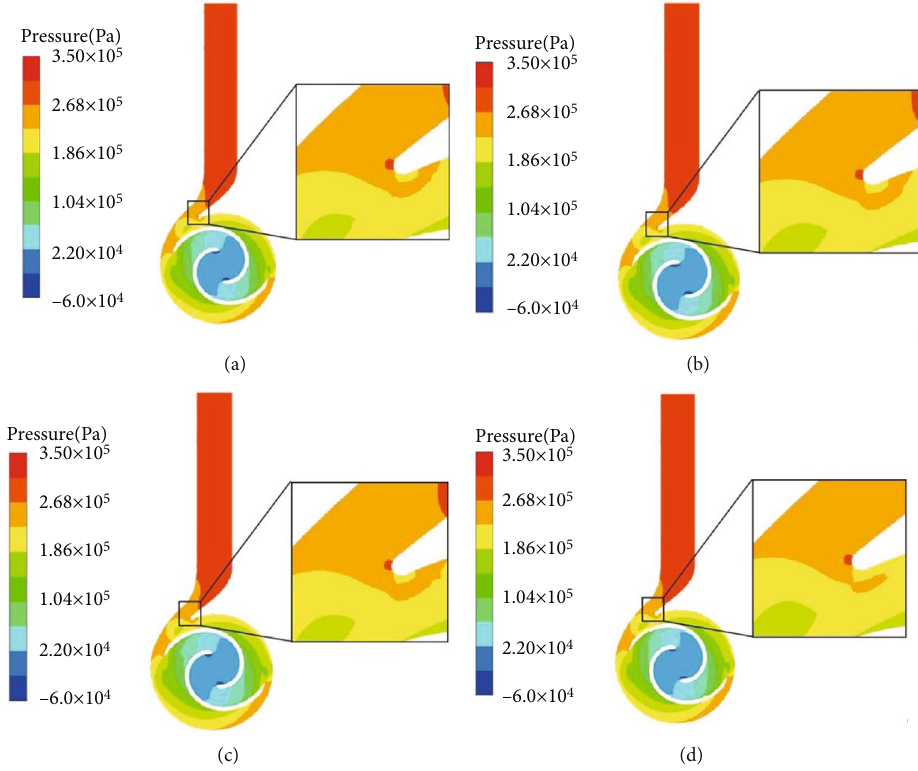
Figure 7: Cross-sectional pressure clouds of four vane double-vane pumps at ρ = 0kg/m 3